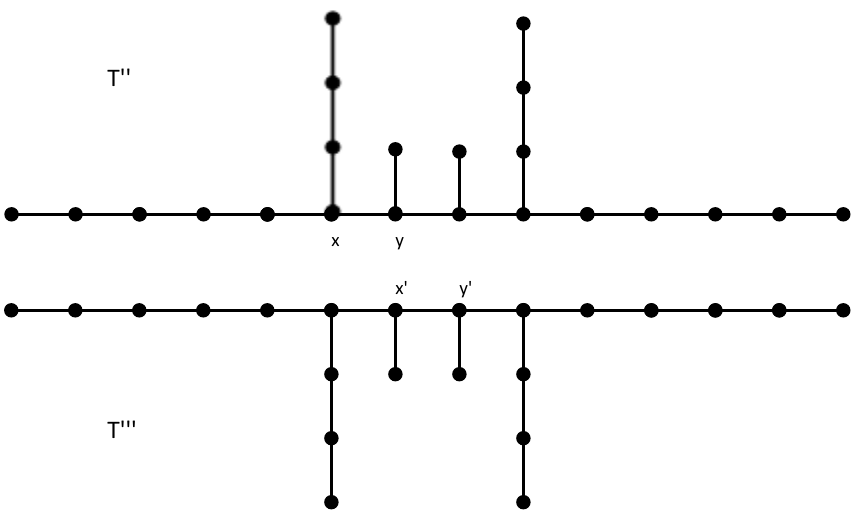
Figure 4: Two identical trees 𝑇 ′′ and 𝑇 ′′′ ; p ( 𝑥 ) = p ( 𝑥 ′ ) and p ( 𝑦 ) = p ( 𝑦 ′ ) but 𝑝 𝑝 ( 𝑥 ′ , 𝑦 ′ ) 5